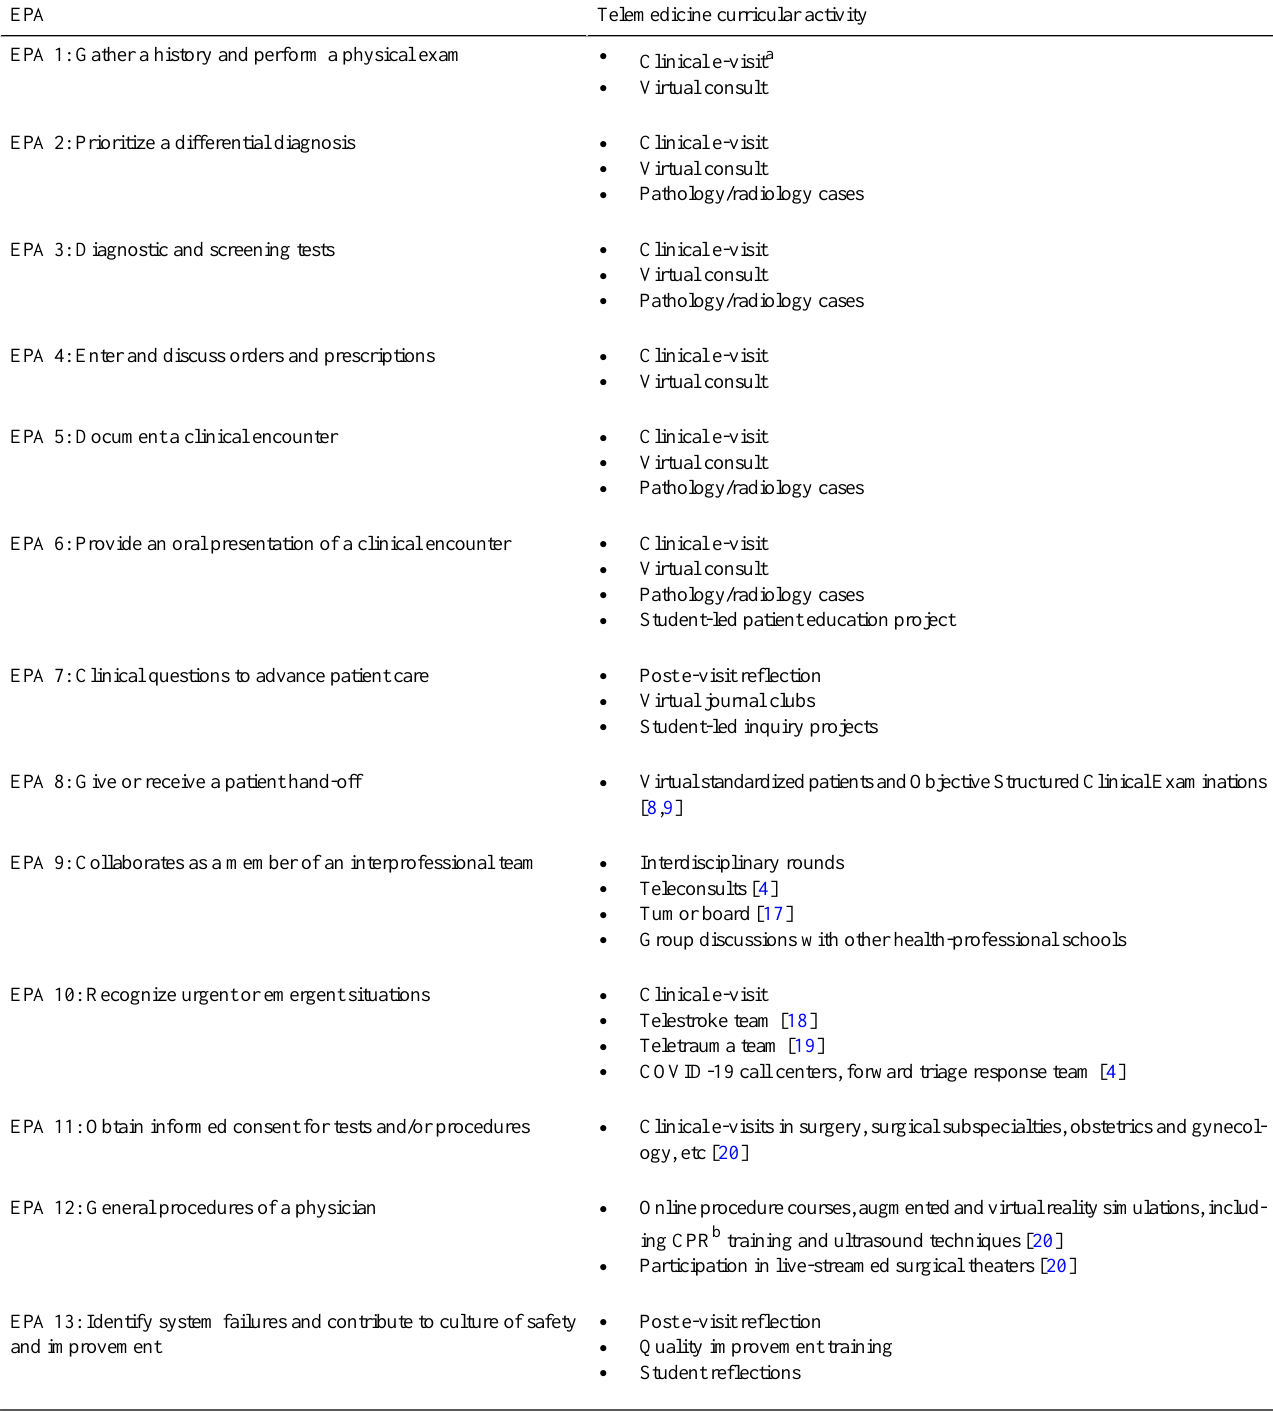
Table 1. Telemedicine curricular activities that align with each of the Association of American Medical Colleges’ Core Entrustable Professional Activities (EPAs)